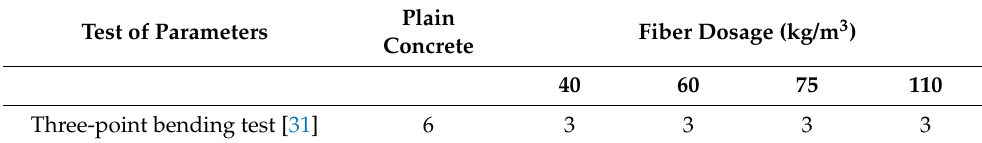
Table 4. Parameters of bending tests and numbers of samples (number).